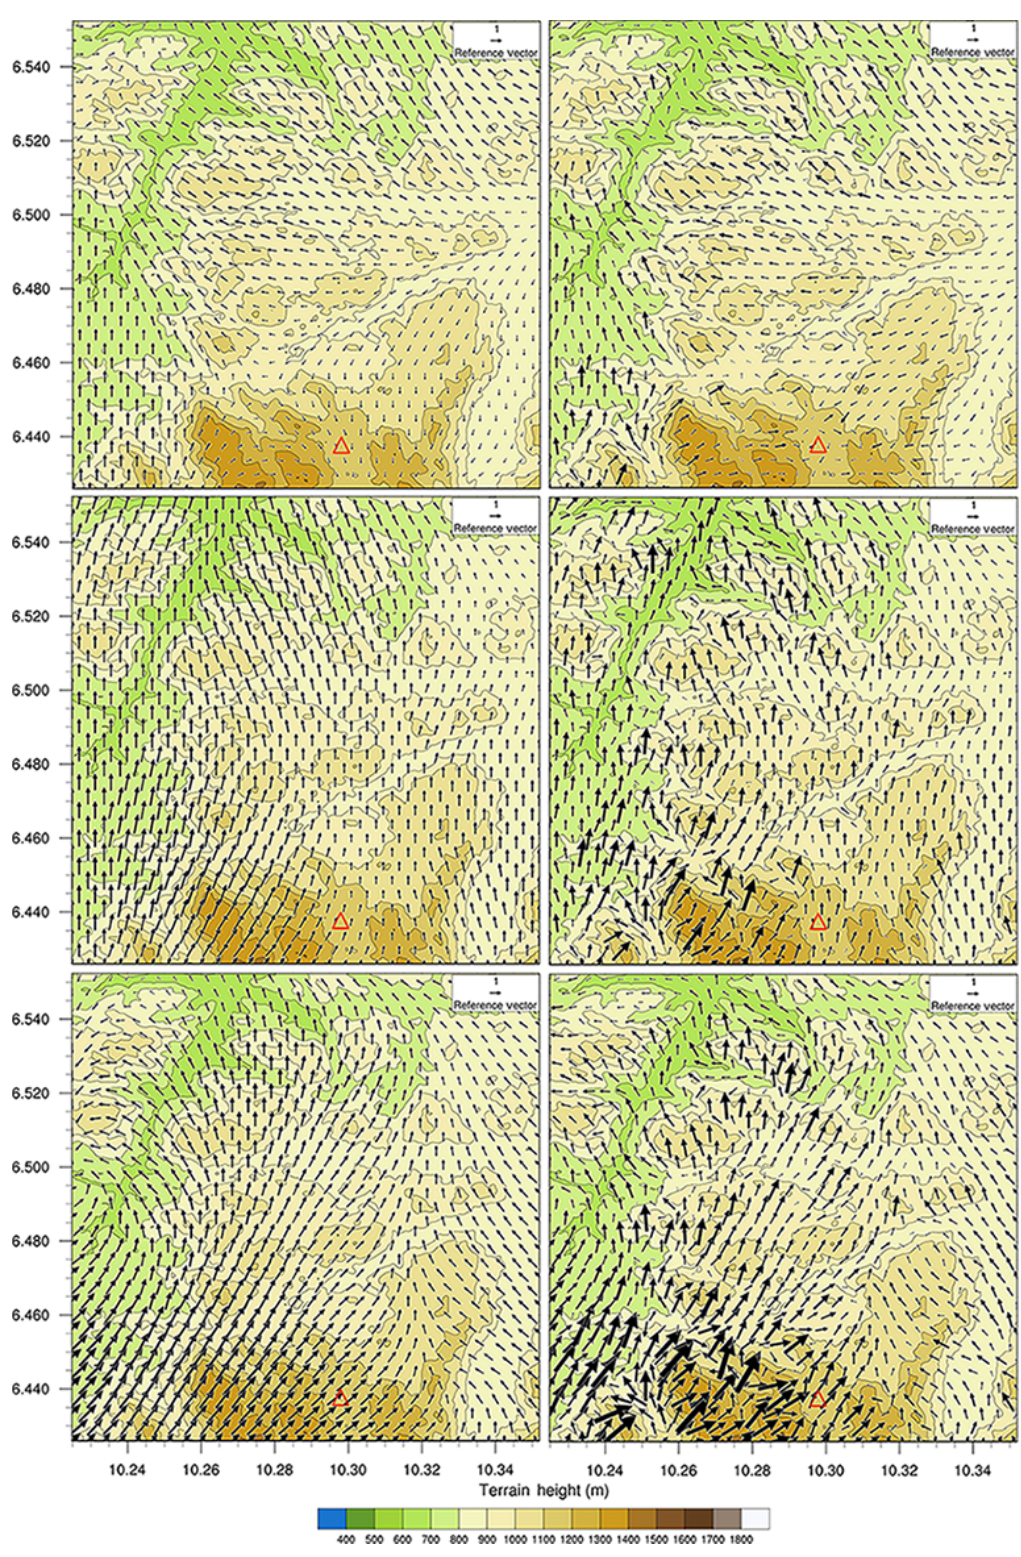
Figure 10. Wind vectors at 10m above terrain as given by WRF-ARW at 3km resolution (left column) and the downscaling (right column) for 21 August 1986 at 18:00 (top), 19:00 (middle), and 21:00 (bottom) UTC. For visualisation and point-to-point comparison purposes, WRF results have been interpolated to the CFD mesh and, when necessary, extrapolated below its lower level. The red triangle shows the location of the Lake